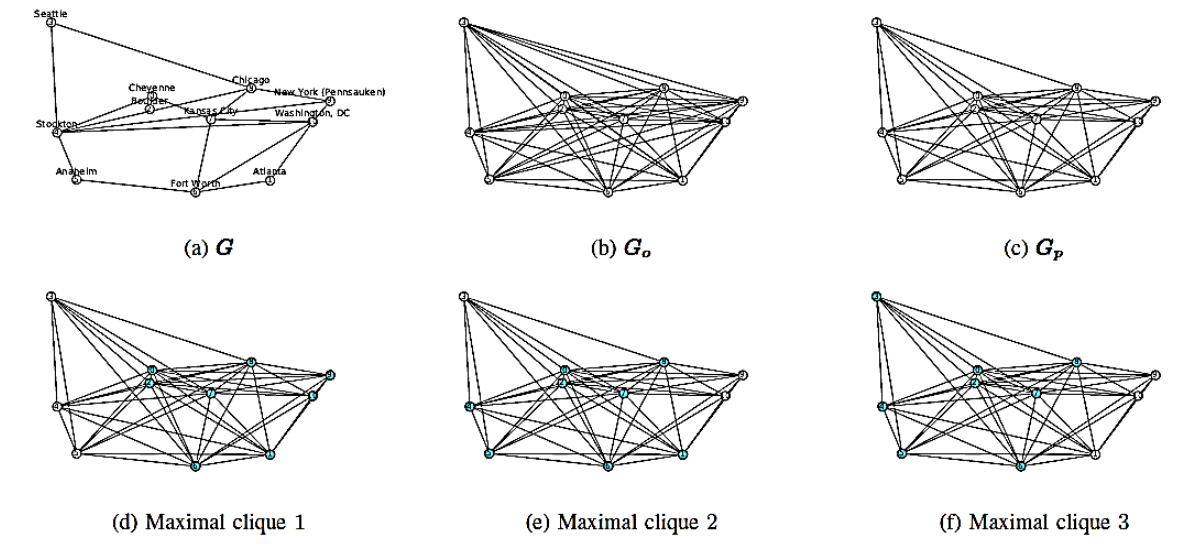
Figure 1. Sprint topology and its illustrations in different phases of Algorithm 1.